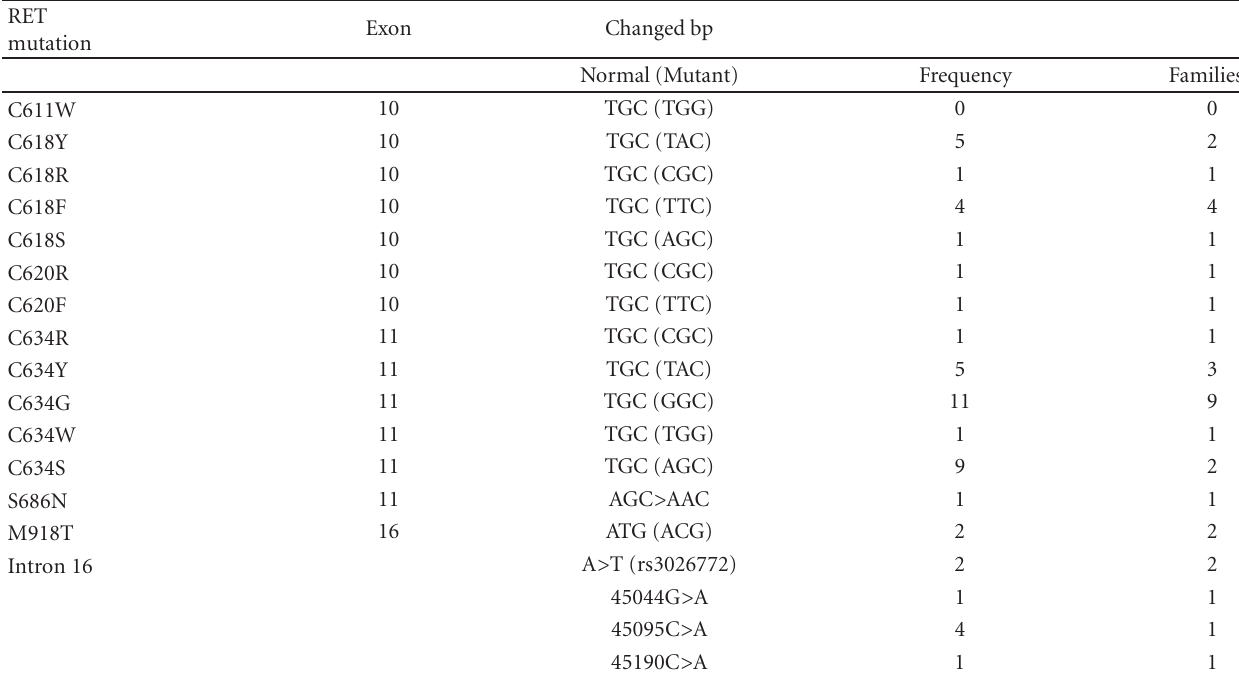
Table 1: Characterization and distribution of RET proto-oncogene germ-line mutations in exons 10, 11, 16, and intron 16 among patients with MTC and their